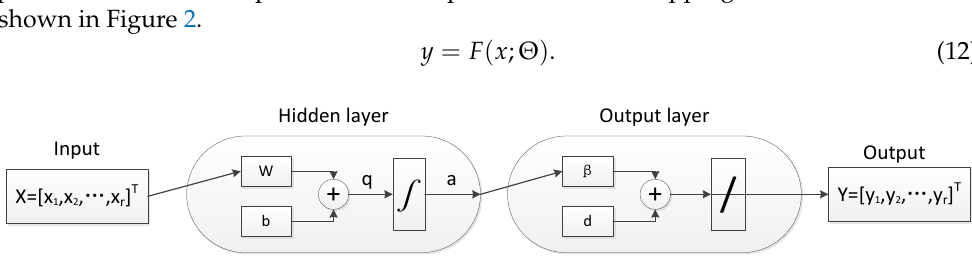
Figure 2. Single hidden layer of an HTBF neural network.